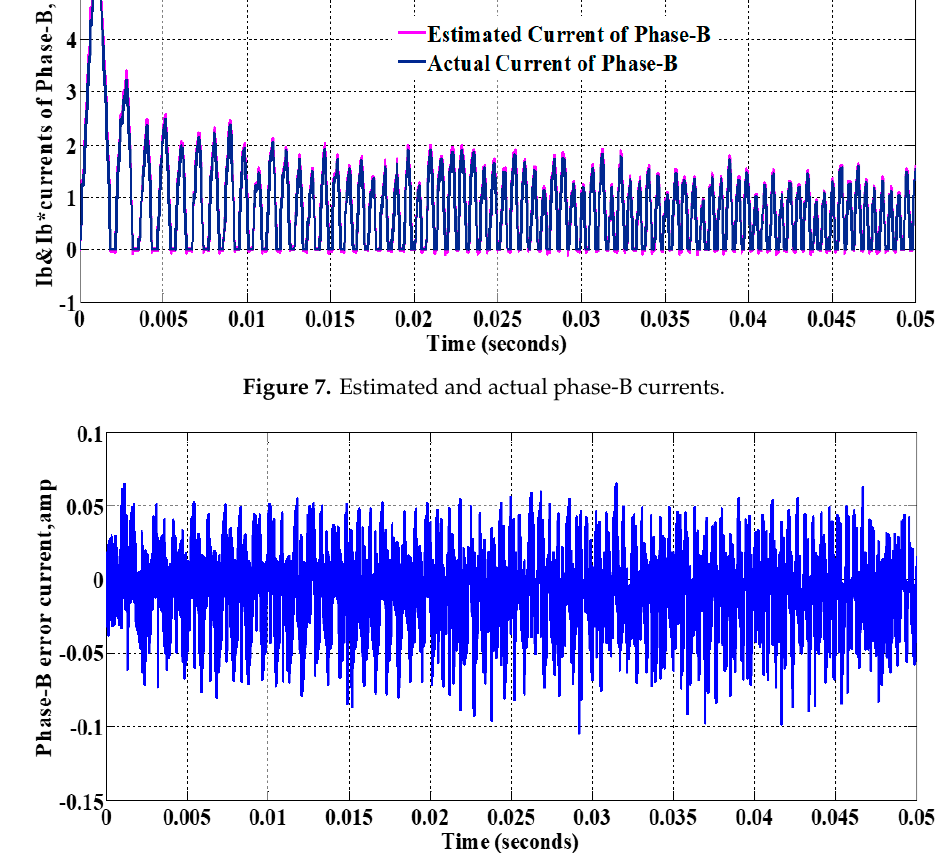
Figure 8. Error between the estimated and actual currents of phase-B.